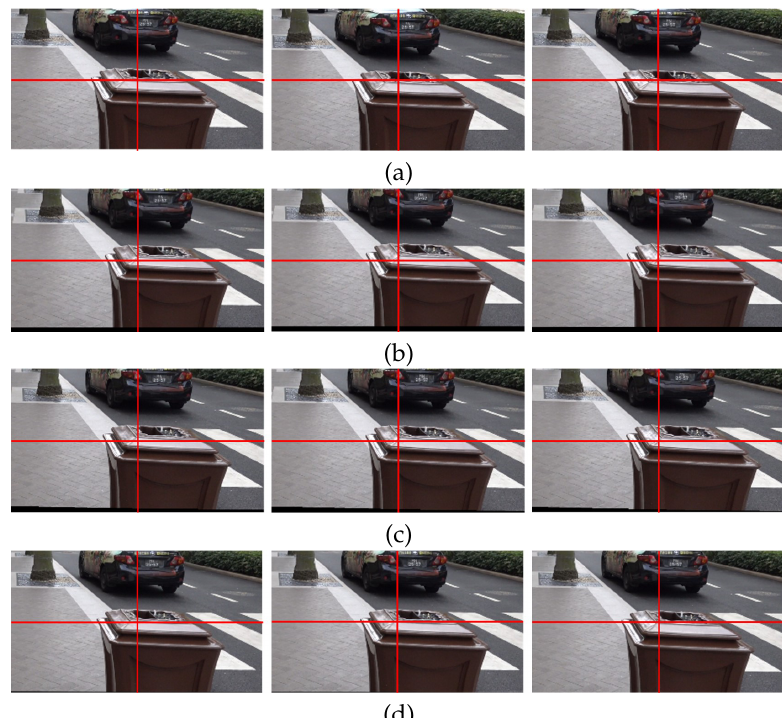
Figure 11. Experimental results of various video stabilization methods: ( a ) the enlarged shaky video frames (170th, 171st, and 172nd frames), ( b ) the stabilized video using the global camera path using feature detection [7], ( c ) the bundled path algorithm [14], and ( d ) the proposed method.